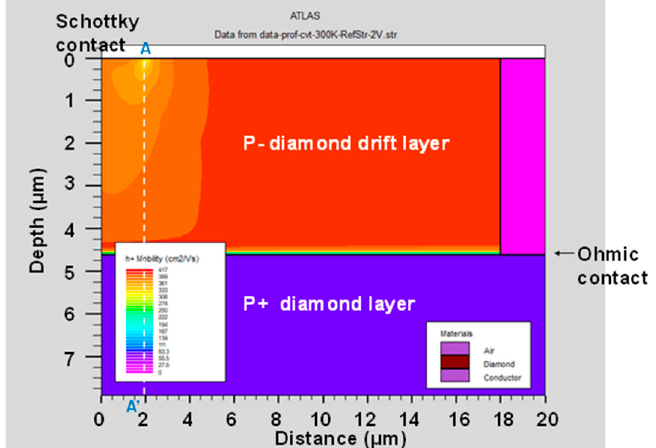
Figure 6. Hole mobility of the p-type diamond pseudo-vertical Schottky barrier diode (SBD) simulated using the Lombardi CVT mobility model. The anode voltage ( V a ) was 2 V at 300 K.